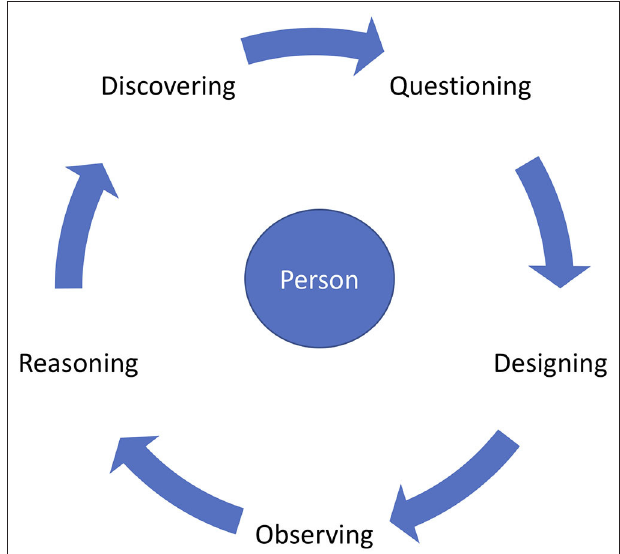
FIGURE 1 | Personal science is defined as the practice of using empirical methods to explore personal questions. This practice is characterized by five kinds of activities and begins with